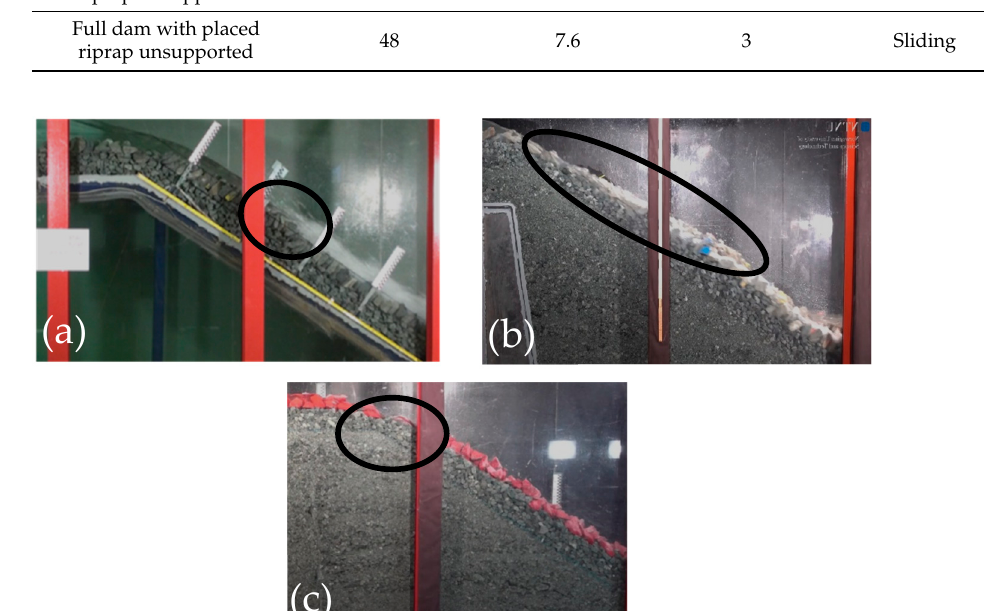
Figure 9. Image of the possible failure mechanisms from all tests with ( a ) buckling ( b ) sliding and ( c ) surface erosion mechanisms.